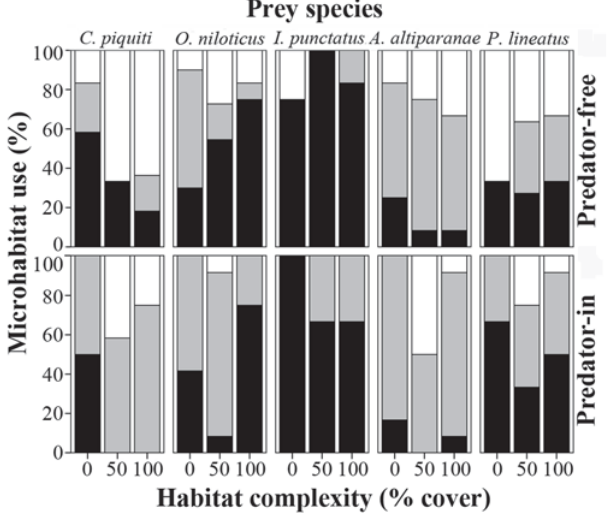
Fig. 4. Microhabitat use (%) of the five different prey species in response to predator presence ( P. corruscans ) and level of habitat complexity. White square = surface, gray square = water column, black square = bottom areas. Top panel = predator-free; bottom panel = predator-in